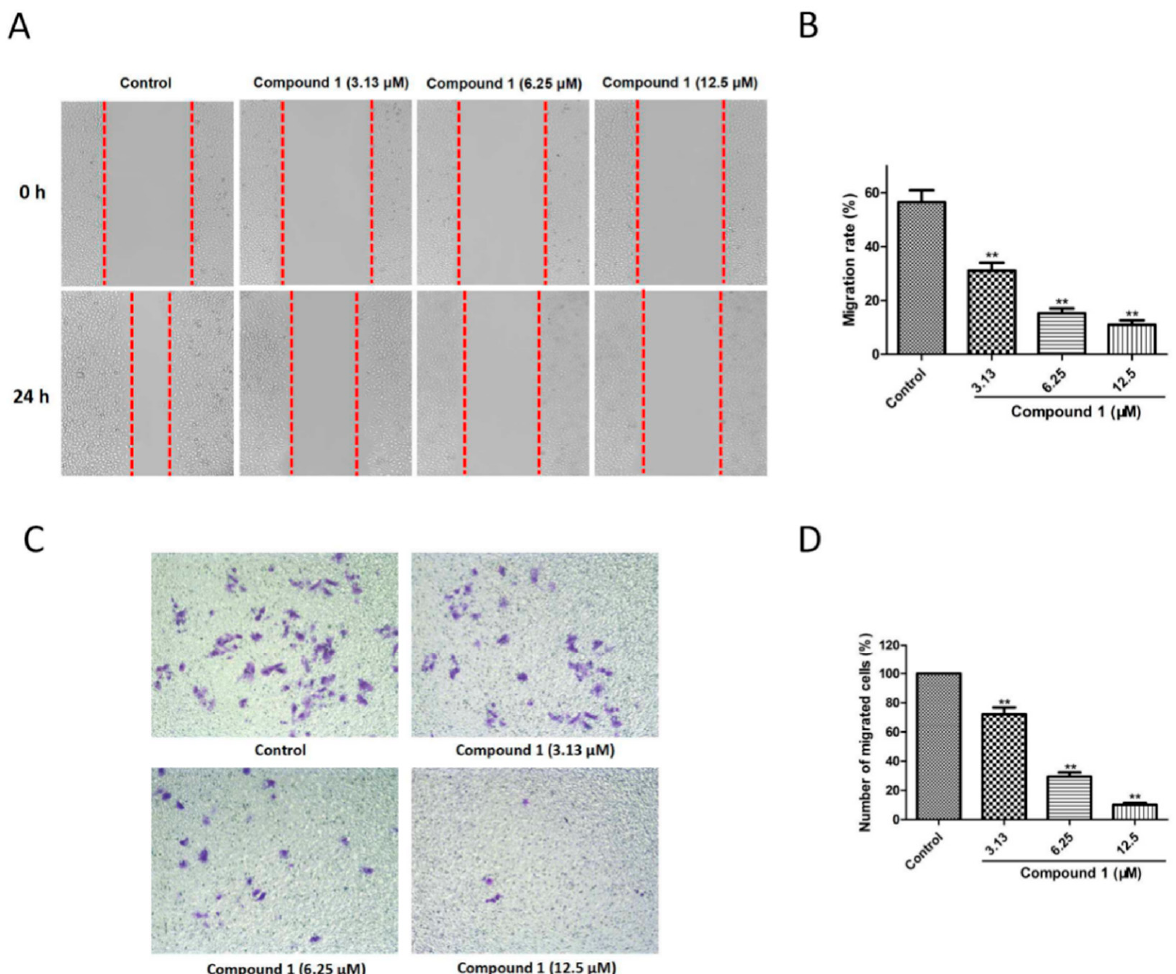
Figure 4. Effect of compound 1 on migration of A549 cells. ( A ) Microscopy images obtained during wound healing assay of control, compound 1 (3.13 μ M), compound 1 (6.25 μ M), and compound 1 (12.5 μ M) groups. ( B ) Treatment with 3.13, 6.25, and 12.5 μ M of compound 1 markedly decreased the migration rate. ( C ) Microscopy images acquired during transwell migration assay of control, compound 1 (3.13 μ M), compound 1 (6.25 μ M), and compound 1 (12.5 μ M) groups. ( D ) Treatment with 3.13, 6.25, and 12.5 μ M of compound 1 dramatically reduced the migrated cell numbers. Data are shown as the mean ± SD ( n = 3). ** p < 0.01 in comparison with the control group.